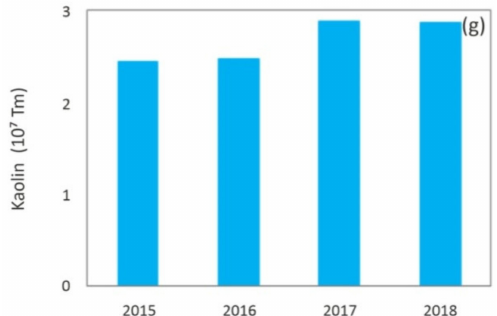
Figure 2. Worldwide production of: ( a ) Iron ore mineral [3]; ( b ) Countries with the largest smelter production of alu- minum [4]; ( c ) Boron [5]; ( d ) Molybdenum [6]; ( e ) Lithium [7]; ( f ) Coal [8]; ( g ) Kaolin